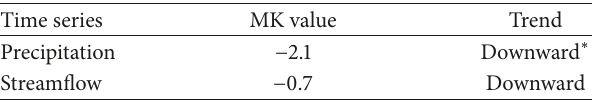
Table 1: MK test result of annual precipitation and streamflow during 1954–2010.